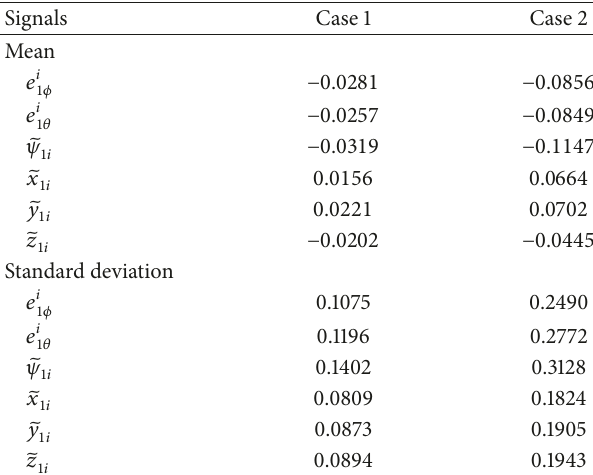
Table 4: Comparison results in Cases 1 and